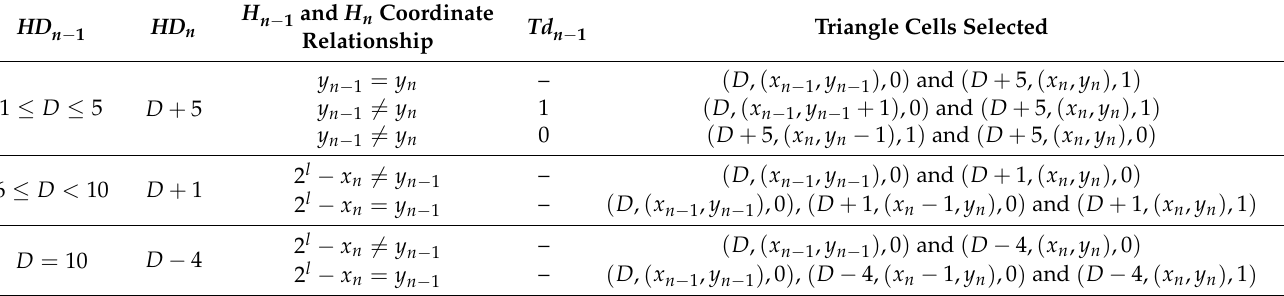
Table 5. Htotcode rule of the ( n − 1)th hexagon cell B 2